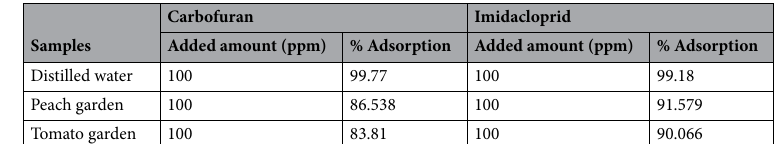
Table 6. Removal of the pesticides from real water samples.